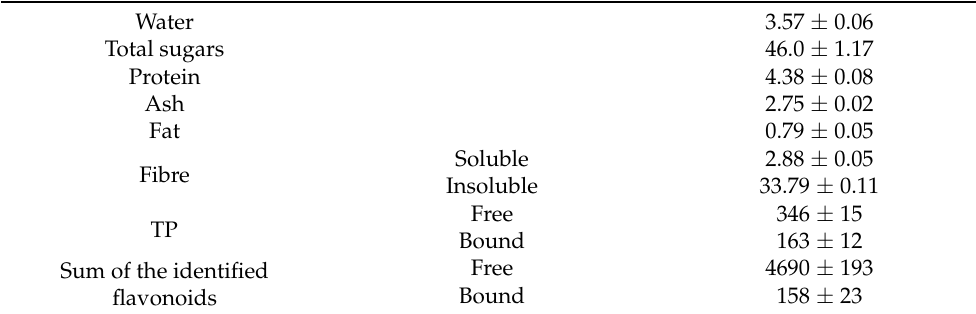
Table 1. Water, total sugars, protein, ash, fat, fibre content (g/100 g sample) of powdered co-product. Total content of free and bound phenols (TP, mg GAE/100 g (db)) and the sum of the identified flavonoids (mg/100 g (db)) of the powdered